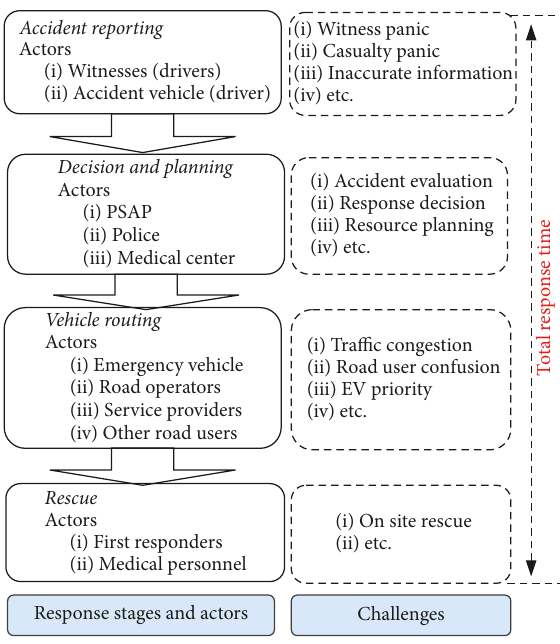
Figure 1: Emergency management phases and